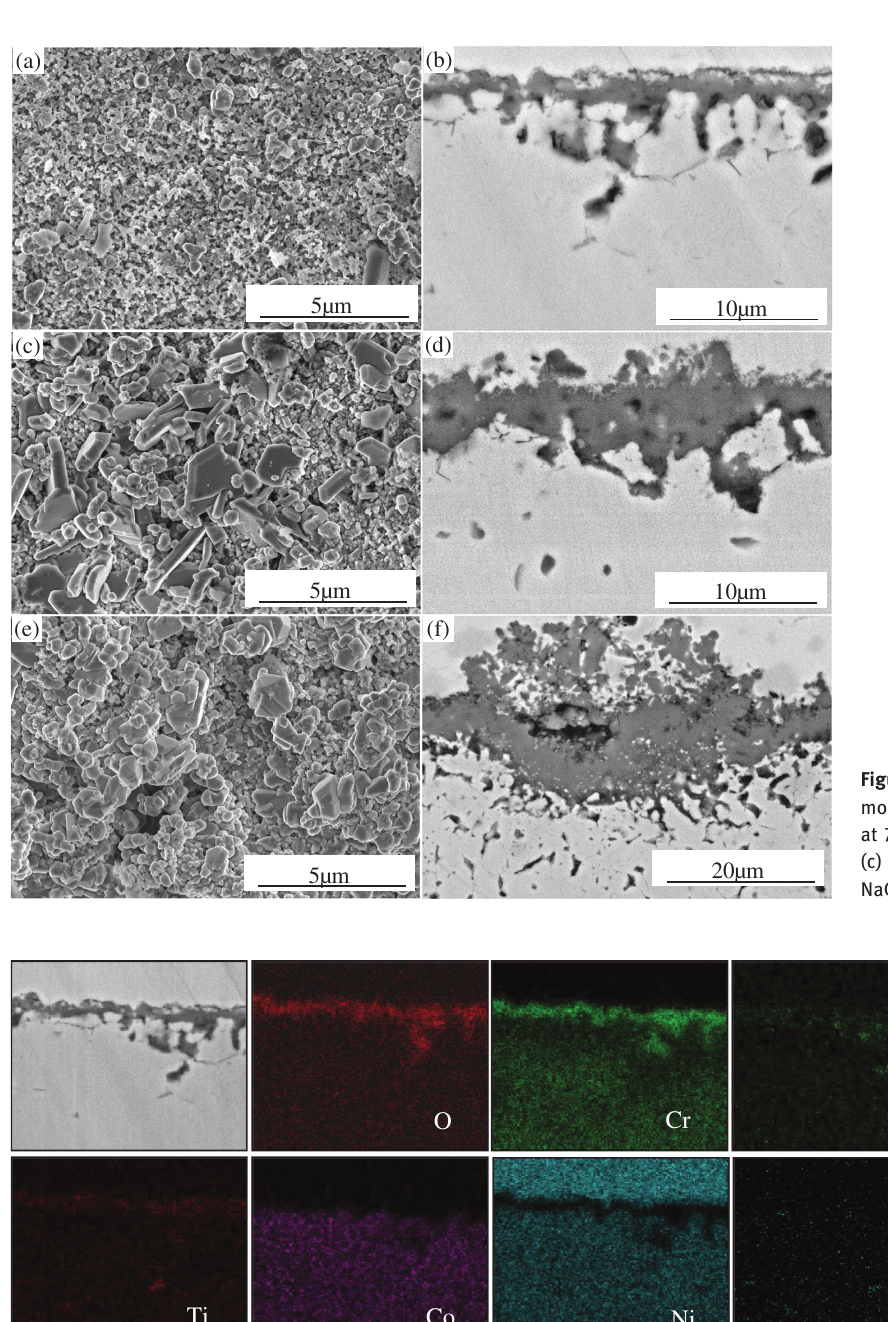
Figure 5: EDS elemental mapping analysis of the corroded samples at 750°C for 500h with 0.1% SO 2